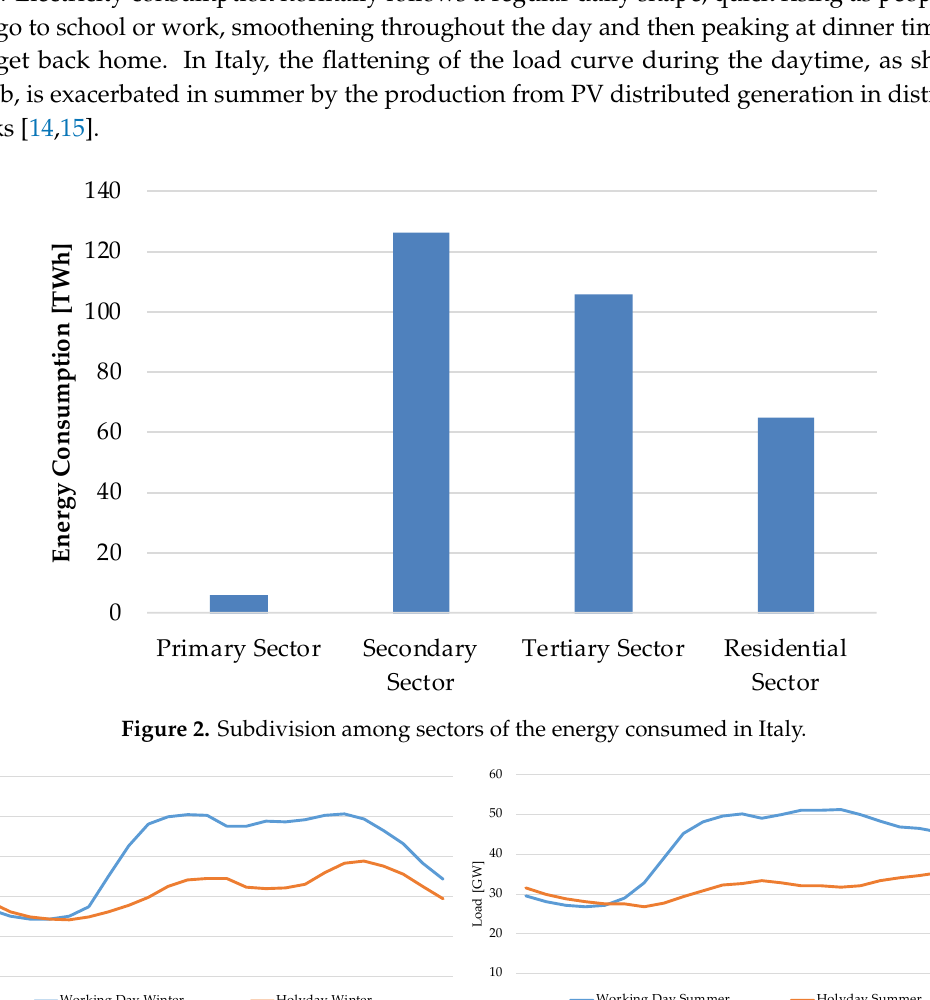
/ Weekend (January / Winter) ( b ) (July / Figure 3. Load profile ( a ) Weekday/Weekend (January/Winter) ( b ) (July/Summer). Figure 3. Load profile ( a ) Weekday